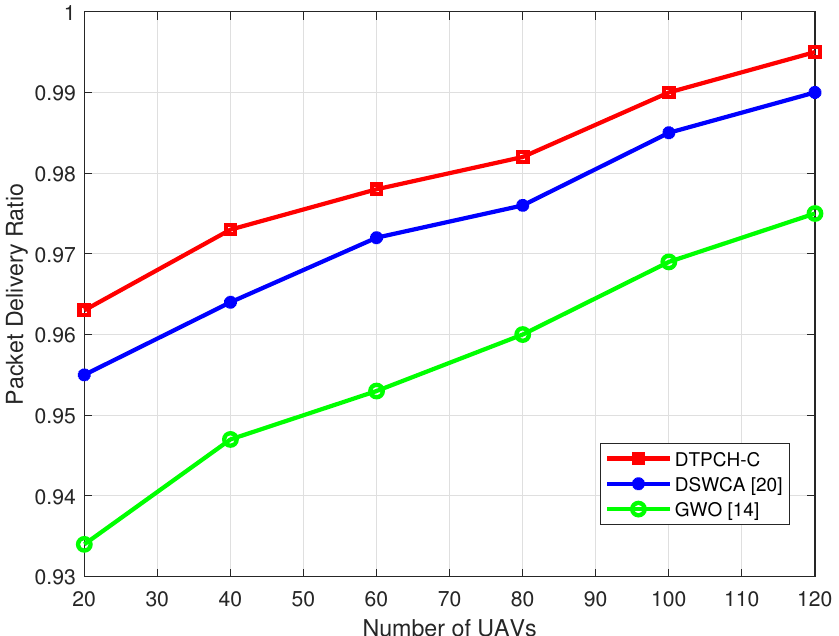
Figure 11. Packet delivery ratio of different clustering schemes with varying numbers of UAV nodes.